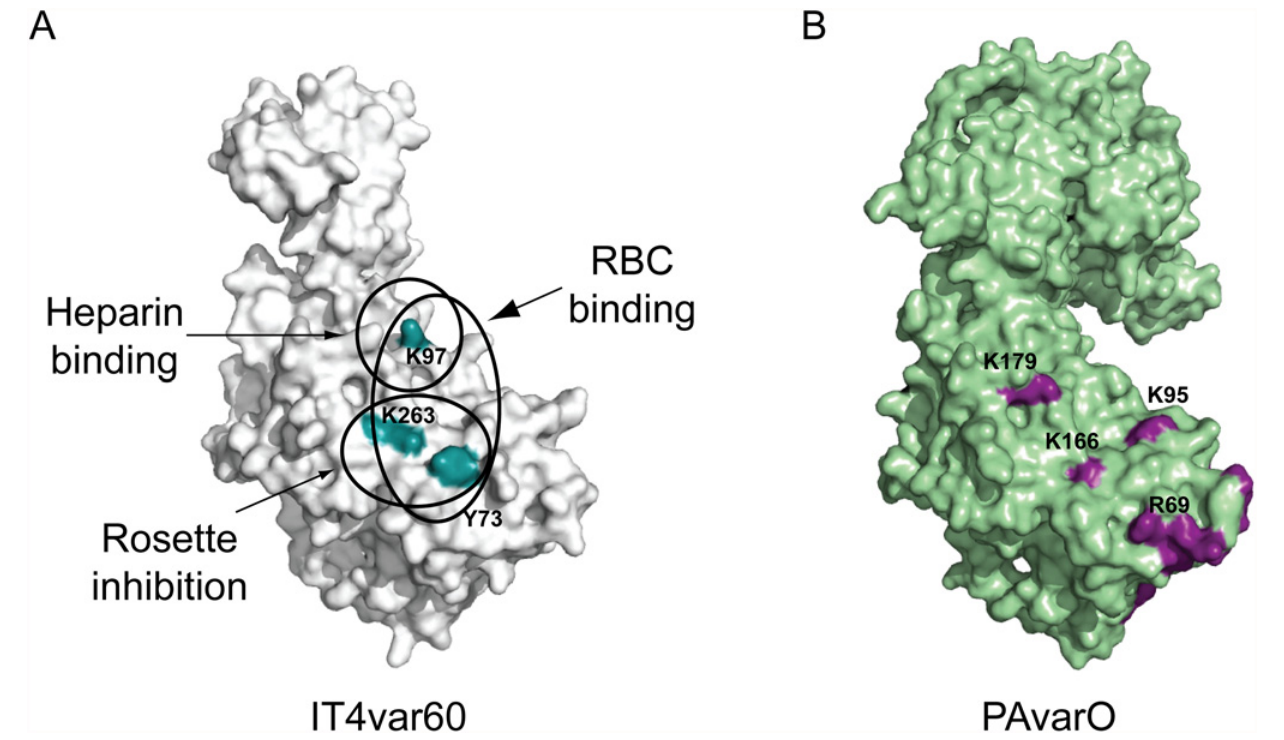
Fig 5. RBC and receptor binding site of NTS-DBL1 α IT4var60. A) Molecular model of NTS-DBL1 α IT4var60 showing the residues involved in RBC binding (Y73, K97 and K263), rosette inhibition (Y73 and K263) and heparin binding (K97). B) Comparison with previously identified residues that are important for BgA binding to the PAvarO variant (K179, K95, K166, R69: purple) [21].